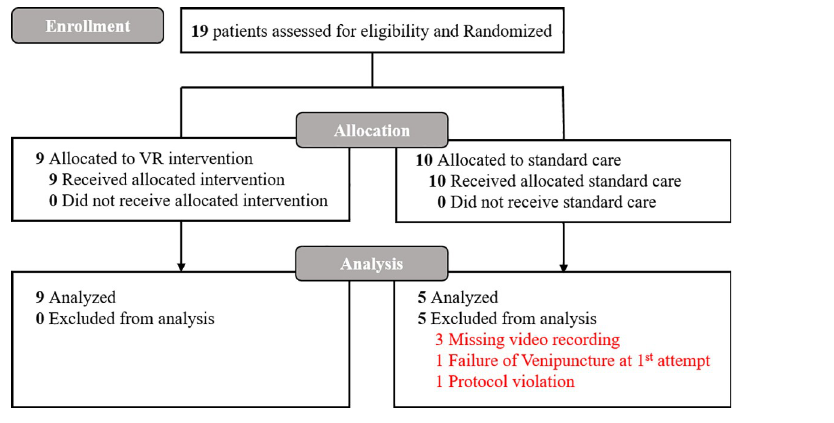
Fig 1. Enrollment and randomization of participants in the